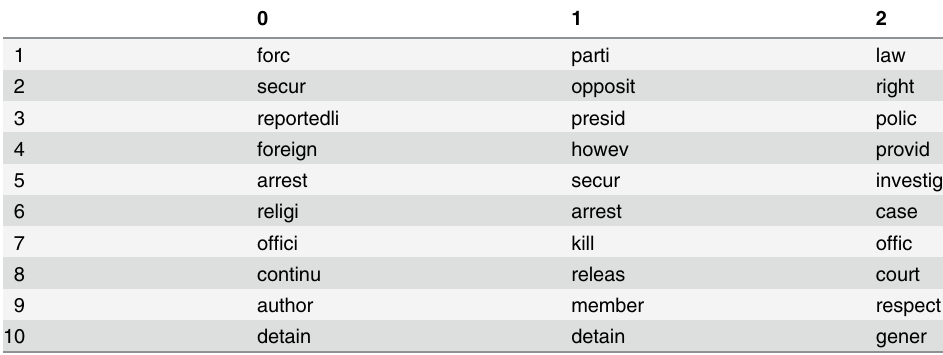
Table 8. Ten most important words for the CIRI Freedom of Domestic Movement variable. 0